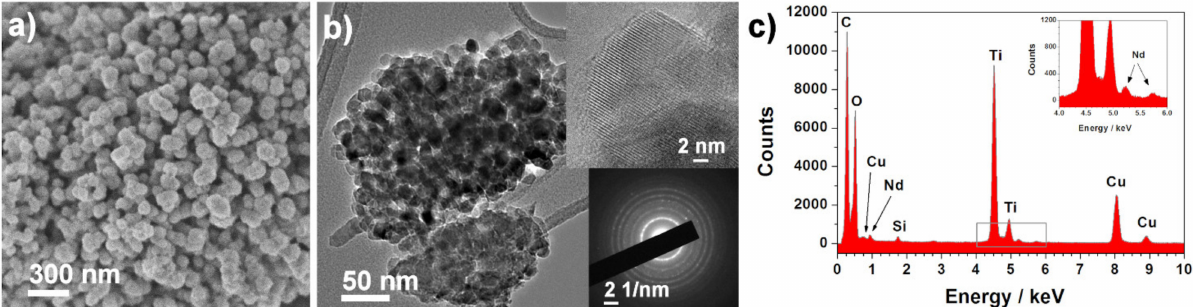
Figure 2. ( a ) SEM and ( b ) TEM images with corresponding SEAD pattern (bottom inset), and ( c ) EDX spectrum of the 3-Nd–TiO 2 sample. EDX spectrum ( c ) was taken over an area presented in Image ( b ). Upper inset in Image ( b ) shows a crystalline particle, the interlayer distance is 0.37